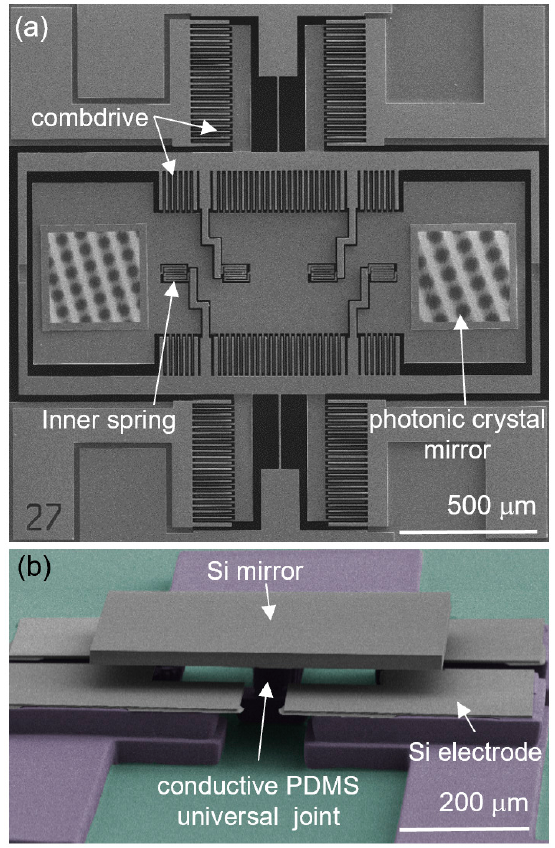
Figure 11. Colored SEM images of ( a ) a MEMS scanner with assembled photonic crystal mirrors and ( b ) a micromirror with a highly doped Si (grey) mirror on a conductive PDMS universal joint (purple). Reproduced with permission from [95,96].